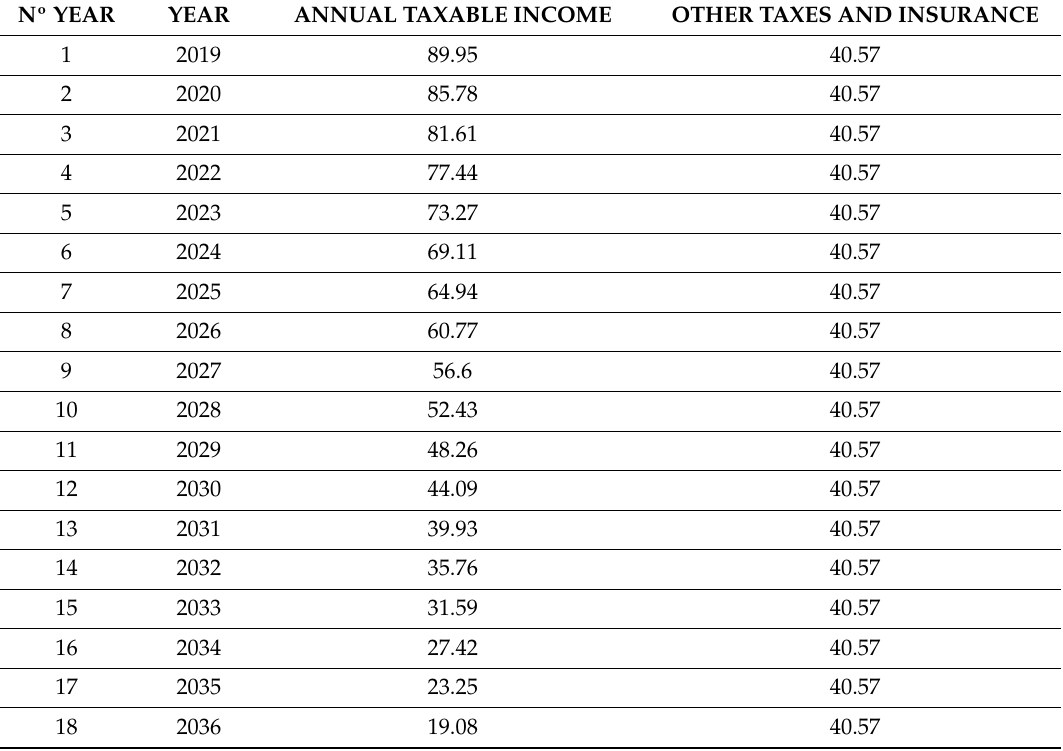
Table A7. Calculated taxes and insurance (in millions of